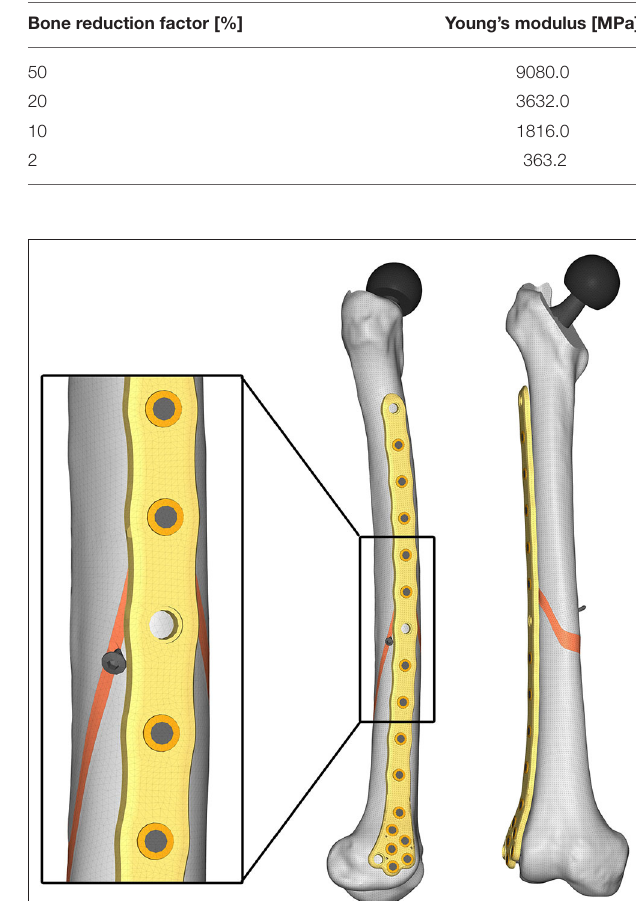
FIGURE 6 | Lateral (Left) and anteroposterior (Right) views of the obtained mesh. component pairs: bone-screw, bone-prosthesis, screw-bushing, and bushing-plate. The bone-plate contact was neglected after verifying that no contact occurred between the two components under all load